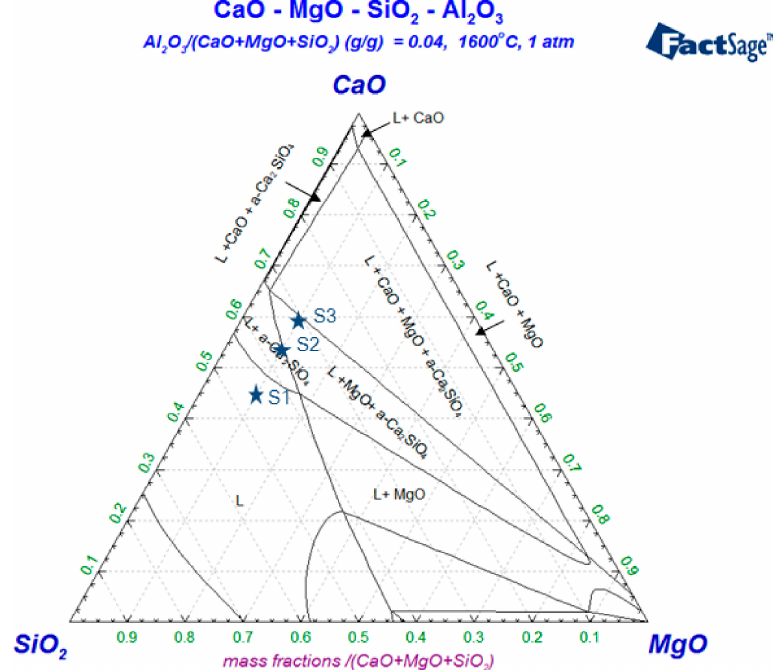
Figure 4. Isothermal section diagram of the CaO–SiO 2 –MgO–4%Al 2 O 3 slag